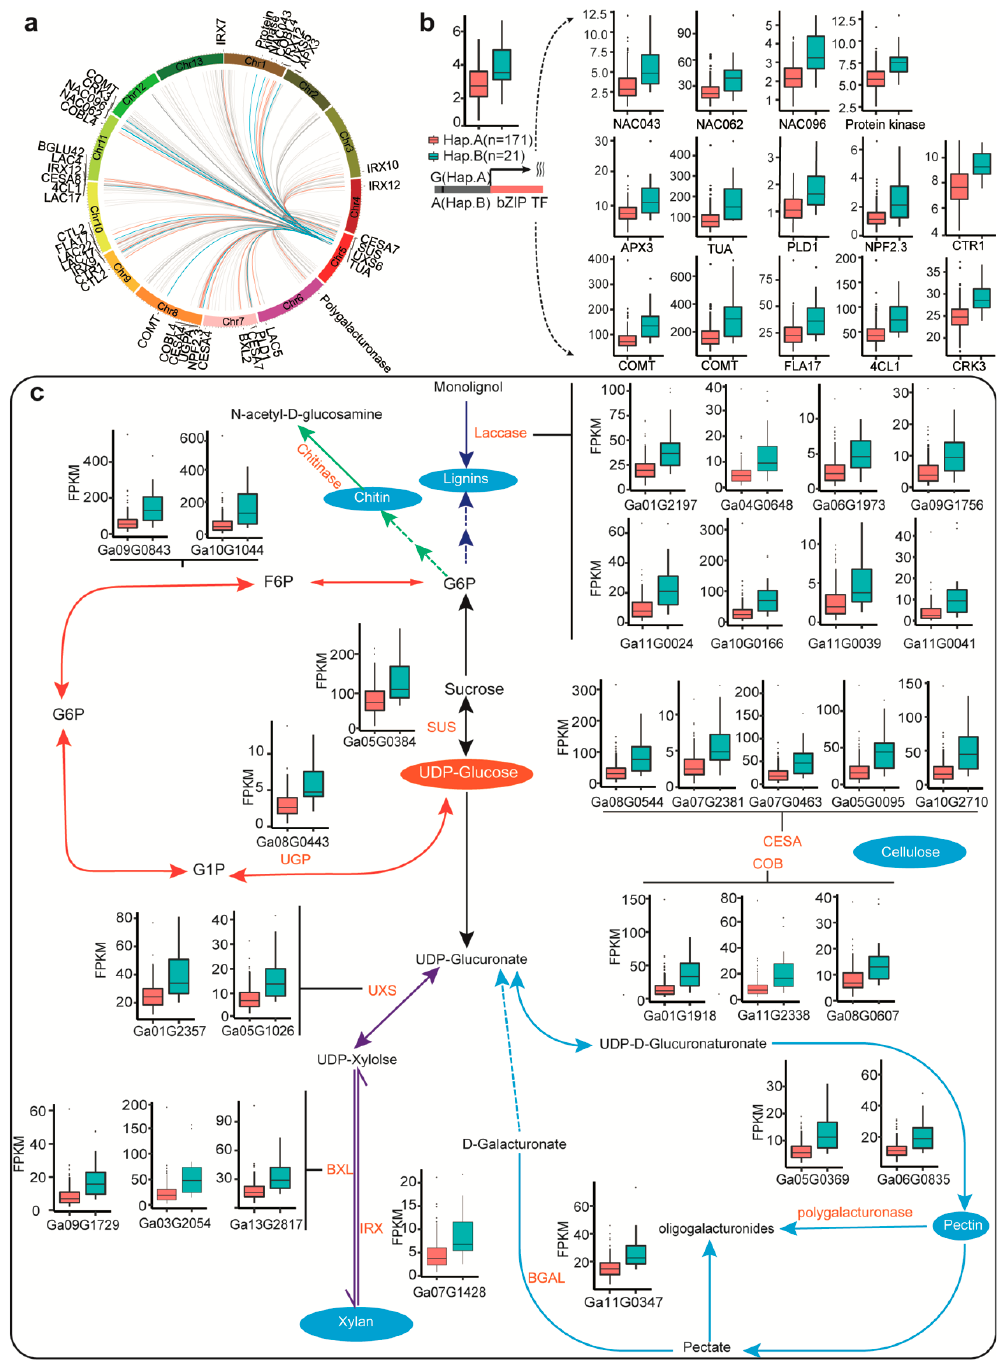
Figure 4. Genes regulated by the trans-eQTLs hotspot 309 are related to cell wall biosynthesis and salt stress. ( a ) The 29 genes involved in cell wall synthesis and 14 genes involved in salt stress were linked to hotspot 309 on Chr05. ( b ) The divergence of the adjacent candidate gene Ga05G2977 and 14 genes involved in salt stress between different alleles of the lead SNP. ( c ) The divergence of 29 genes involved in cell wall synthesis between different alleles of the lead SNP.